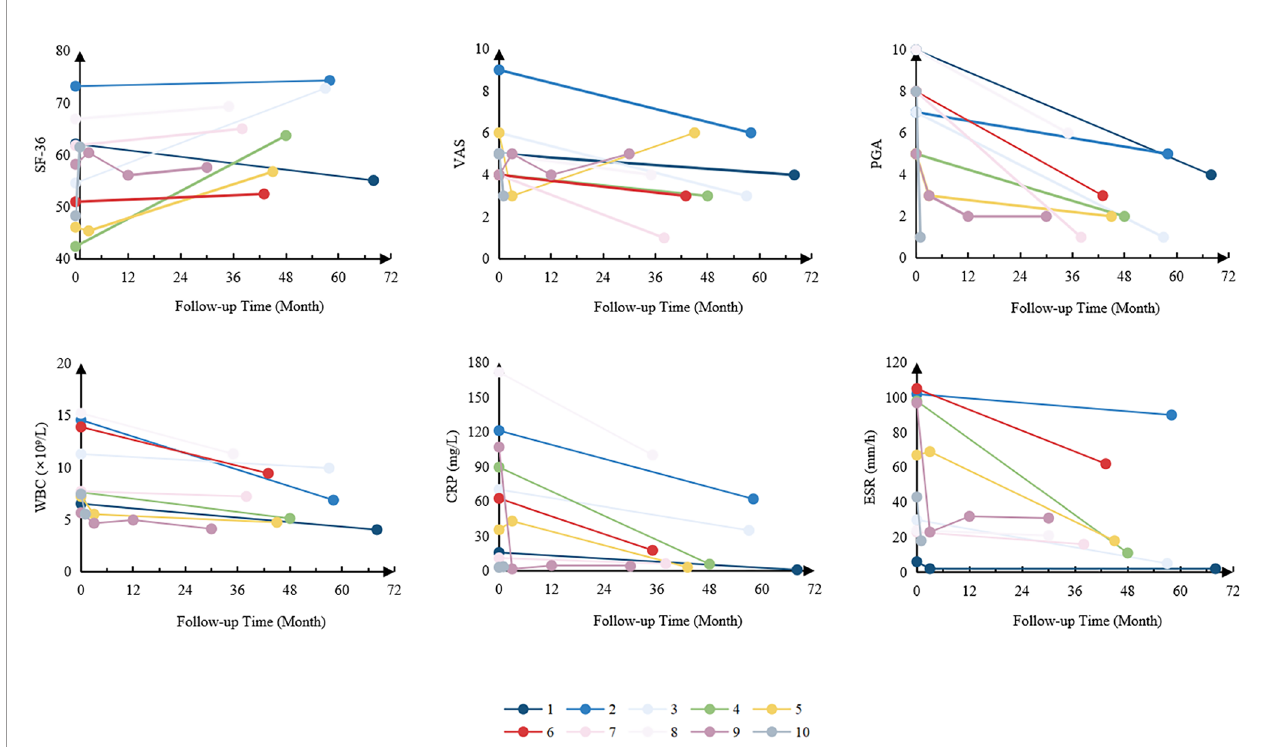
FIGURE 2 | Changes in disease activity of the patients. SF-36, 36-item Short Form; VAS, visual analogue scale; PGA, physician global assessment; WBC, white blood cells; CRP, C-reactive protein; ESR, erythrocyte sedimentation